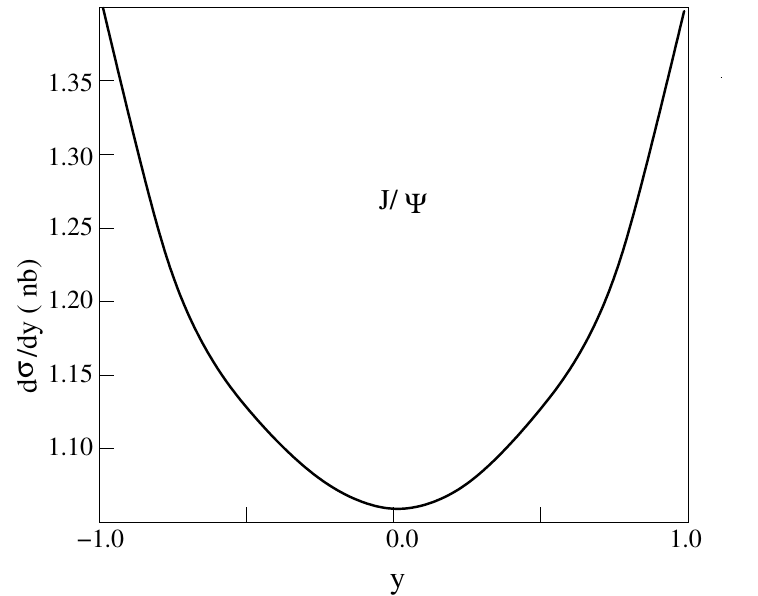
p s pp =5.02 TeV Pb-Pb collisions producing J= (cid:9) with (cid:21) = 0.